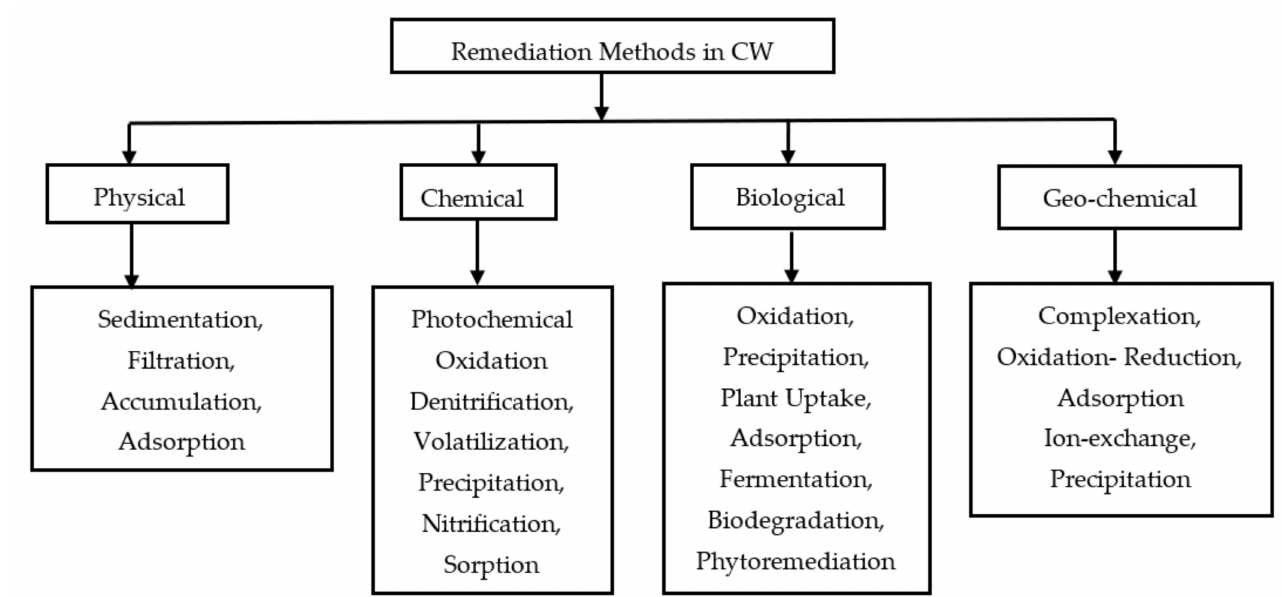
Figure 4. Remediation mechanisms in CW for different